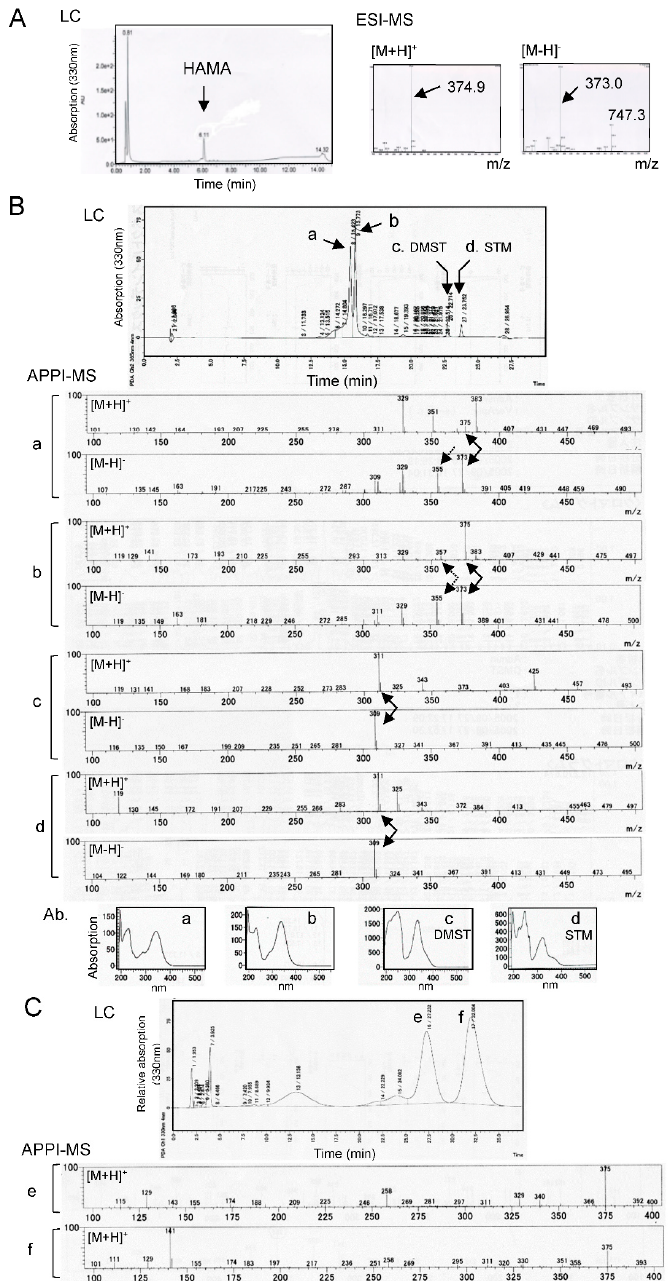
Figure 5. The LC-MS analysis of HAMA produced by the verA disruptant. ( A ) The LC-ESI-MS of HAMA pigment. After HAMA pigment was purified by Diaion HP20, the resulting substance was analyzed by LC-ESI-MS using condition [A]. HAMA (arrow) showed a single peak on LC chromatograms, and its molecular mass was indicated to be 374 on MS chromatogram. ( B ) The LC-APPI-MS of HAMA and its derivatives. The HAMA preparation after the repetition of five-times drying and solubilization (which was the same as the sample in Figure 3E,F), was analyzed by LC-APPI-MS using condition [B]. The mass spectra (middle) and absorption spectra (lower) of each peak (a~d) on the LC chromatogram (upper) are shown. The quasi-molecular ion peaks of each substance and the ion peaks caused by dehydration of the quasi-molecular ion peaks are indicated as solid arrows and dotted ones in the mass spectra, respectively. ( C ) LC-APPI-MS of the extract of the culture medium of the verA disruptant. After the culture medium of the verA disruptant was extracted with ethyl acetate, the resulting extract was analyzed by LC-APPI-MS using condition [C]. The mass spectra of peaks (e,f) on the LC chromatogram (upper panel) are shown